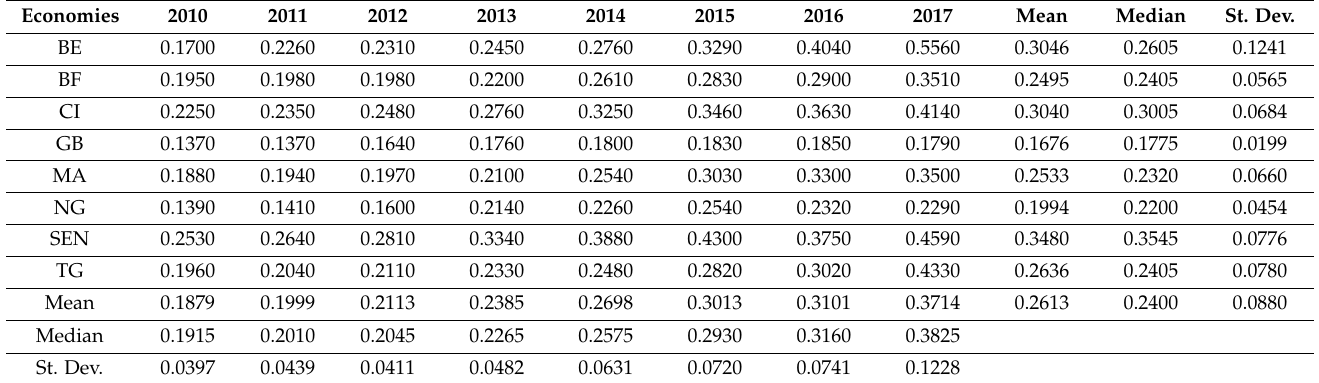
Table 1. ISIF—Descriptive